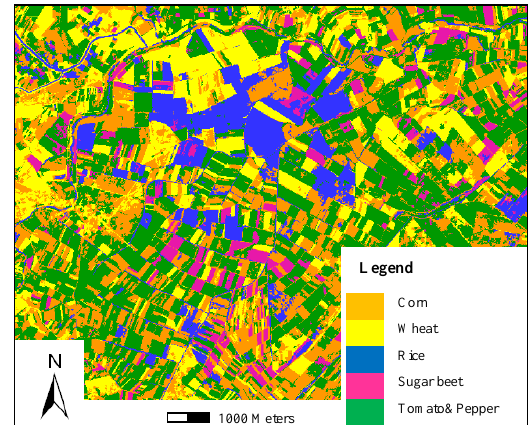
Figure 2 Segmentation results of the area with optimum parameters